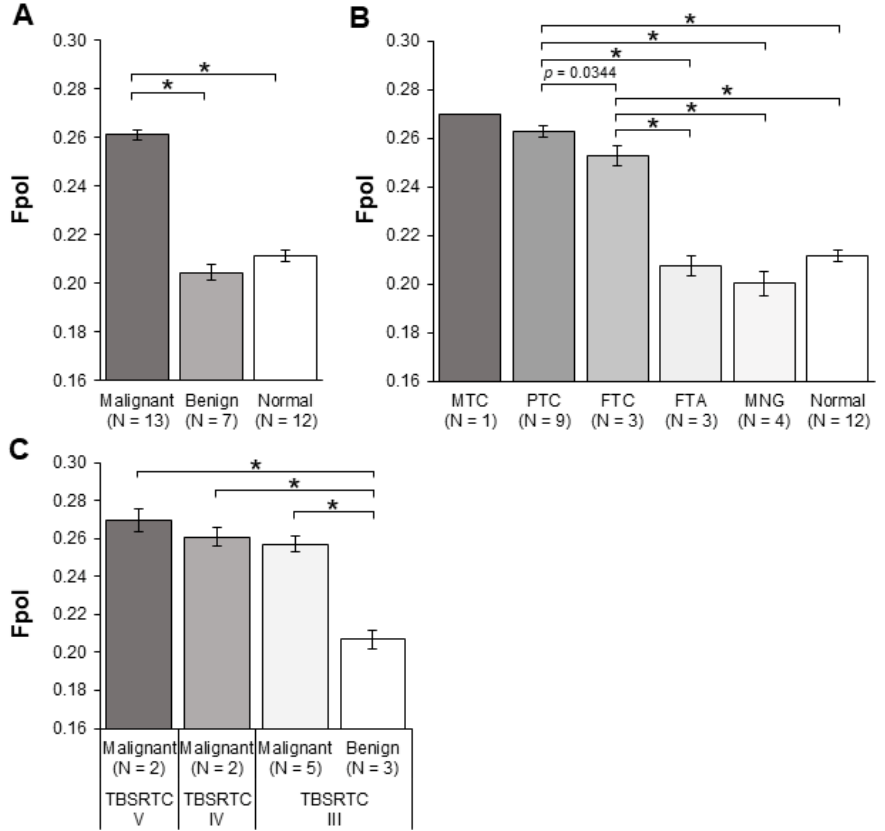
Figure 2. MB Fpol of thyroid samples. ( A ) Average MB Fpol of malignant, benign, and normal sam- ples; ( B ) average MB Fpol of MTC, PTC, FTC, FTA, MNG, and normal samples; ( C ) average MB Fpol of indeterminate samples. Error bars represent standard errors calculated over all samples in the respective group (not determined for single MTC case). N = number of samples. * p < 0.0001.